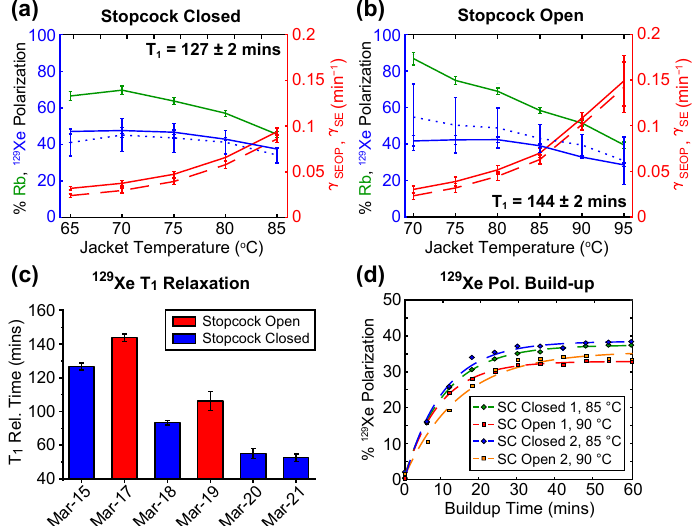
Figure 7. Upper displays ( a , b ) describe steady-state % P Xe , γ SEOP , and % P Rb measurements as a function of SEOP cell surface temperature in a 1000 Torr Xe/1000 Torr N 2 gas mixture fill obtained with the SEOP cell stopcock ( a ) closed and ( b ) open. Note, the solid blue line denotes experimental % P Xe and dashed blue line denotes theoretically predicated % P Xe(theor) based on the experimental values of % P Rb , γ SEOP and 129 Xe T 1 as described previously [67] (see SI). Lower displays show comparisons of ( c ) 129 Xe T 1 values (note the y -axis starts at 40 min to better delineates the differences) and ( d ) 129 Xe polarization build-up curves recorded for the first four experimental points shown in display c—note the consistency in the polarization dynamics for a given cell